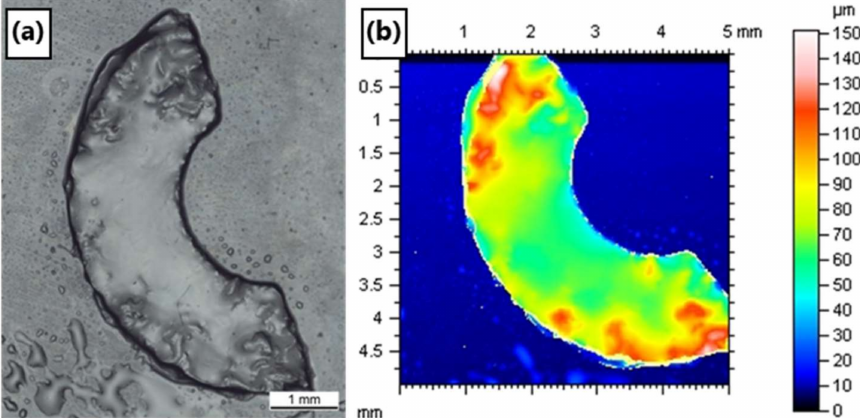
Figure 4. ( a ) Optical microscopy image of soft but freestanding Ceraset green body crosslinked by the 266 nm laser (40 mW power with 10 µ m hatching) and ( b ) optical profilometry image. Green bodies formed by laser crosslinking were examined afterwards by ATR-IR (Figure 5).